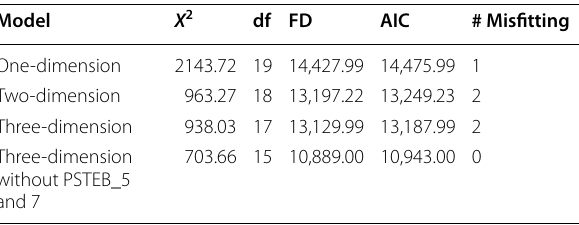
Table 2 Comparison between one, two and three-dimensional models of the T-STEM science scale